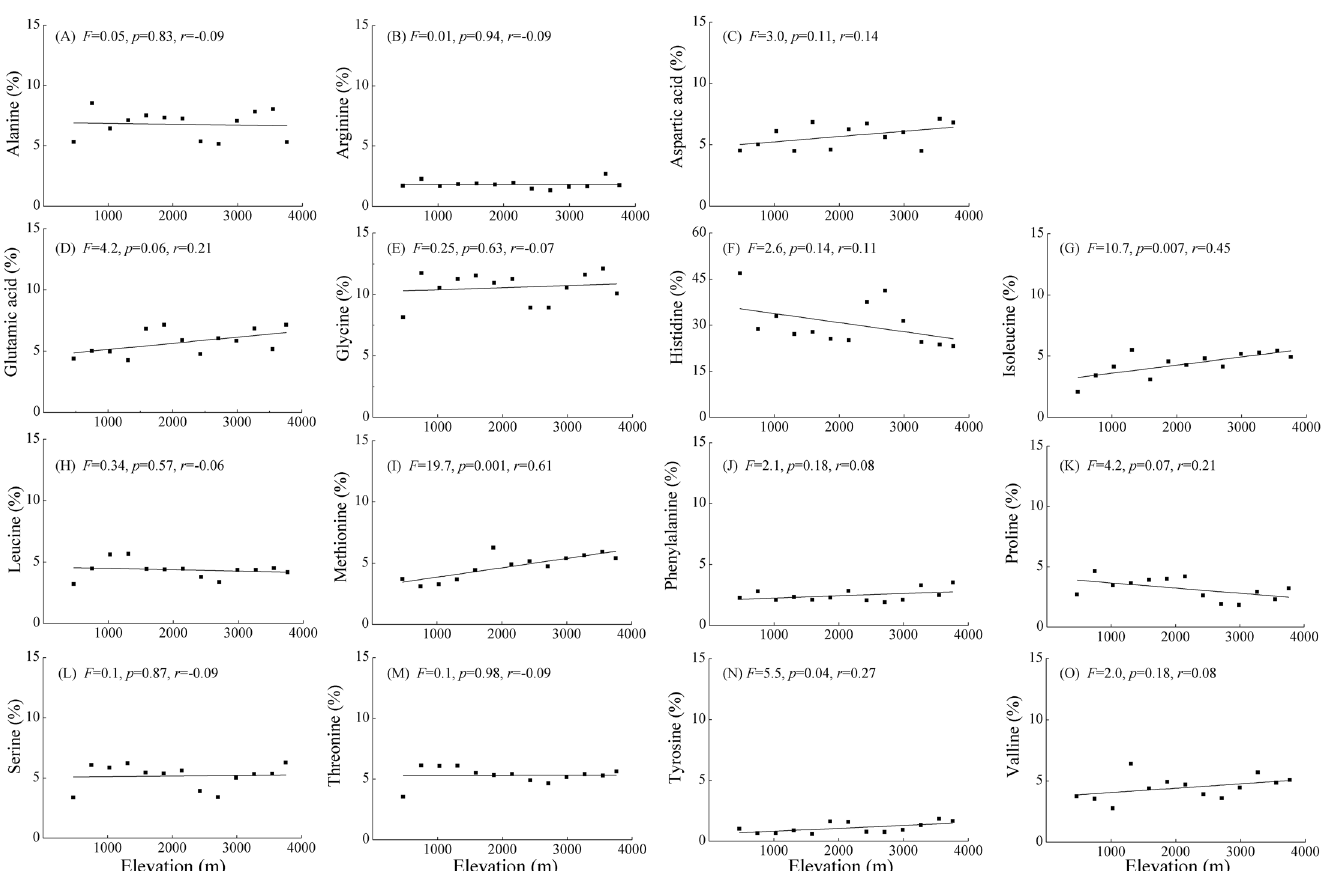
Fig 4. Simple linear regression of the relationships between the composition of individual amino acids contained in PC1 and elevation. The best-fit lines, F values, goodness of fit ( r ) and p -values are